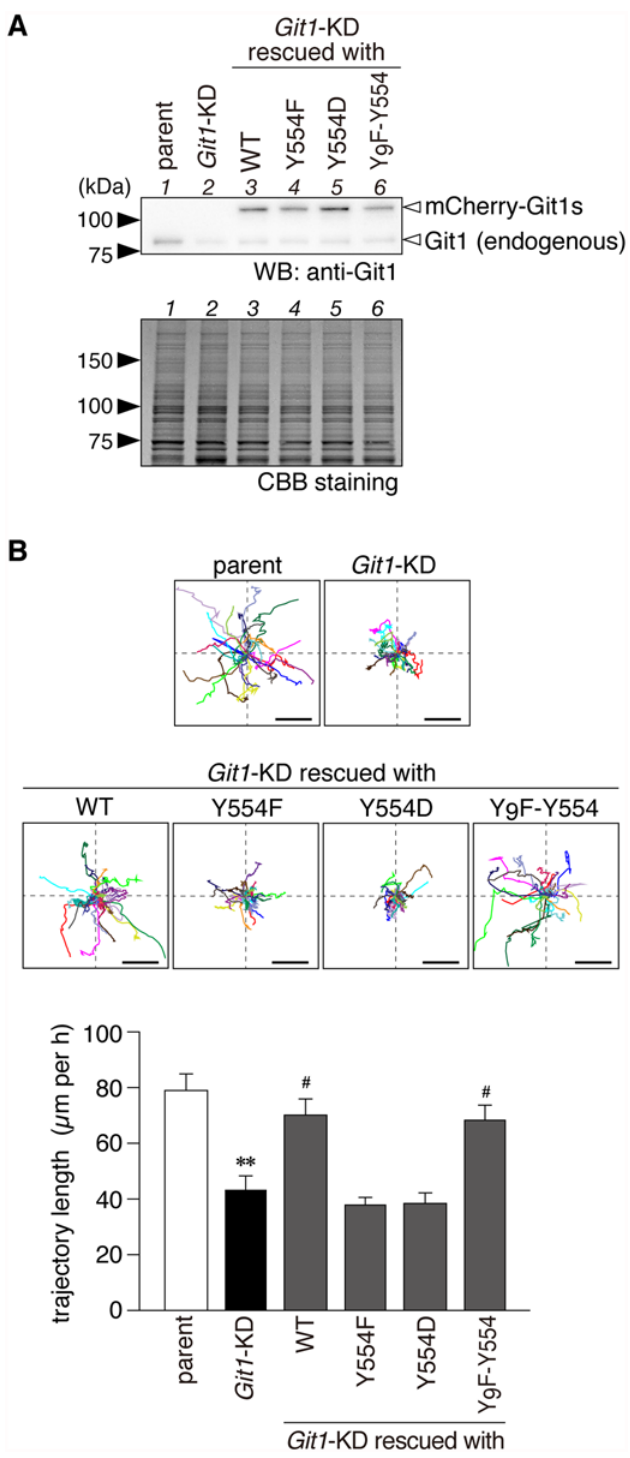
Fig 7. Git1 Tyr-554 mutants failed to restore impaired cell motility by Git1 knockdown in a random cell motility assay. A , Western blotting of Git1 expression in parental A7r5 cells, Git1 -knockdown ( Git1 -KD) cells, and Git1 -KD cells exogenously expressing the mCherry-fused Git1 mutants (WT, Y554F, Y554D, and Y 9 F-Y554). Both the endogenous Git1 and mCherry-fused Git1 mutant proteins were detected with anti-Git1. The protein amounts applied were verified by CBB staining. B , Wind-Rose plots of individual cell trajectories